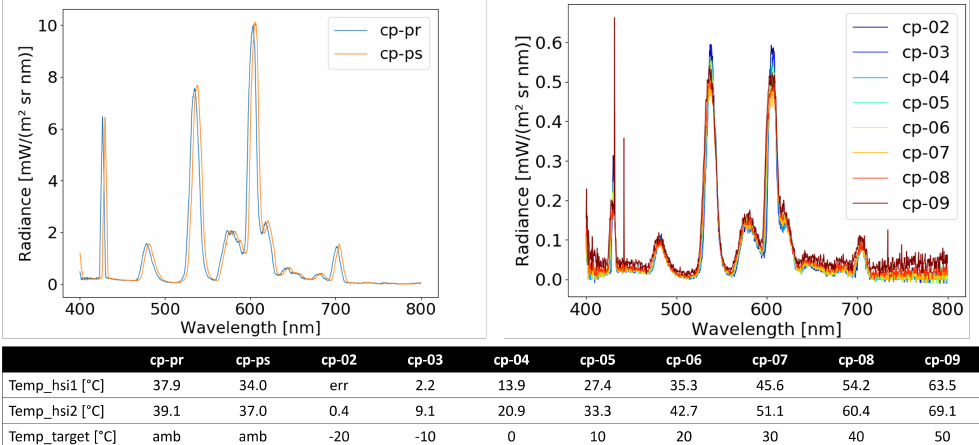
Figure 16. ( Left ) Spectral response of the QM HSI pre (pr) and post (ps) TVAC testing: white paper illuminated by an external fluorescent light source. ( Right ) Spectral response of the QM HSI at varying temperatures inside the TVAC chamber: metallic chamber interior illuminated by an external fluorescent light source. Note that the y-axes are not equal—the light intensity is stronger in the pre/post testing setup than in the chamber. Cropping was performed according to the quantum efficiency of the sensor, as stated in Figure 14. ( Bottom ) The table summarizes temperatures recorded during testing—Temp_hsi1 is from inside the imaging sensor housing before powering the camera on; Temp_hsi2 is the same sensor, but recorded after running a test script/imaging, which simulates a typical overpass activity; Temp_target shows the environmental target temperature of the chamber/setup. CP = Characterization Point, amb = ambient room temperature (assume 22 ± 5 ◦ C), err = error (the imager cannot report negative